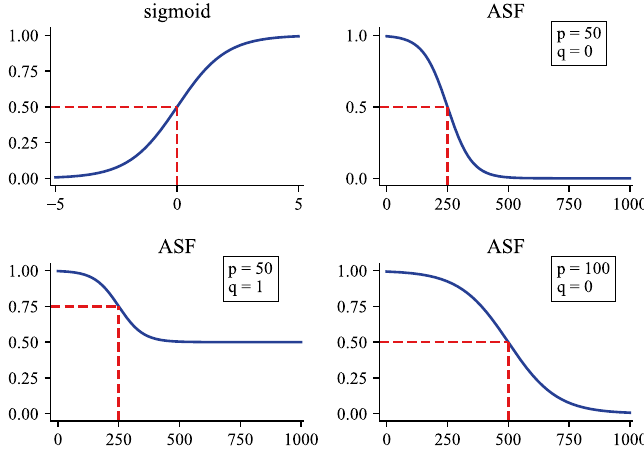
Figure 2. Sigmoid and ASF function. The upper left figure shows the original sigmoid function. The comparison of the upper right and lower left figures shows that the more information is remained with the larger parameter q . The comparison of the upper right and lower right figures shows that the active period of link information is determined by the parameter p .